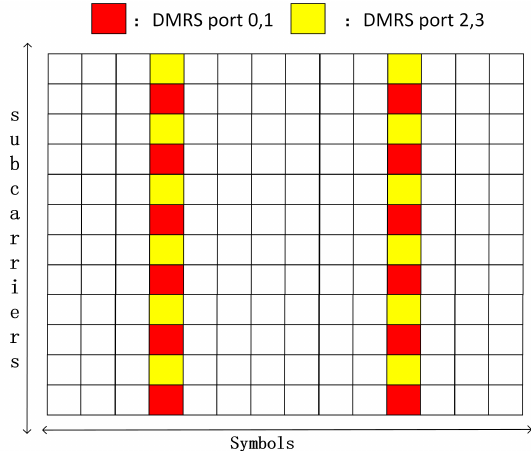
Figure 2. Schematic diagram of single-symbol DMRS pilot type